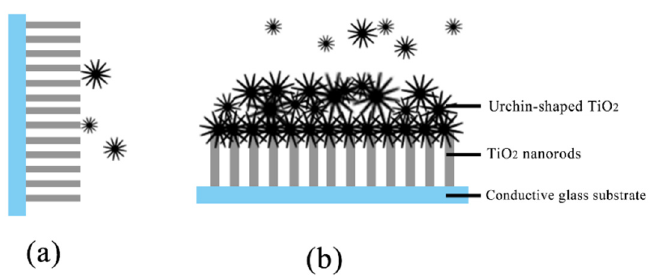
Figure 5. Generation mechanism diagrams of TiO 2 nanoarrays and its homojunction: ( a ) Placing the conductive glass vertically; ( b ) Placing the conductive glass horizontally.